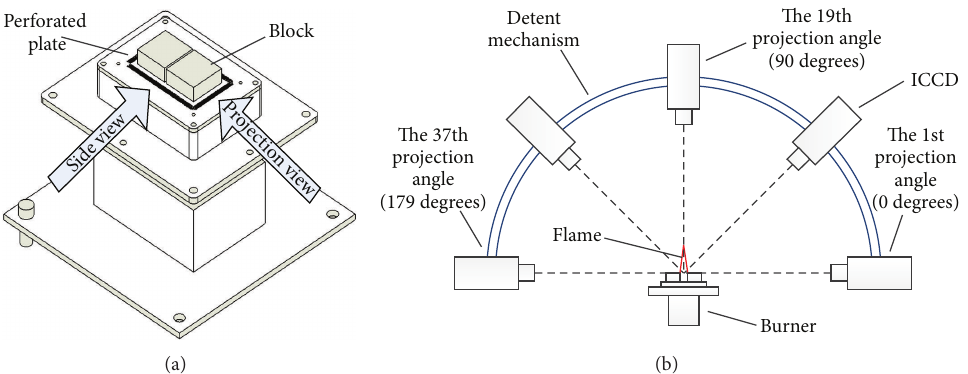
Figure 6: Schematics of the optical system: (a) two typical view orientations; (b) a single camera mounted on a guideway and rotated around a fixed center.